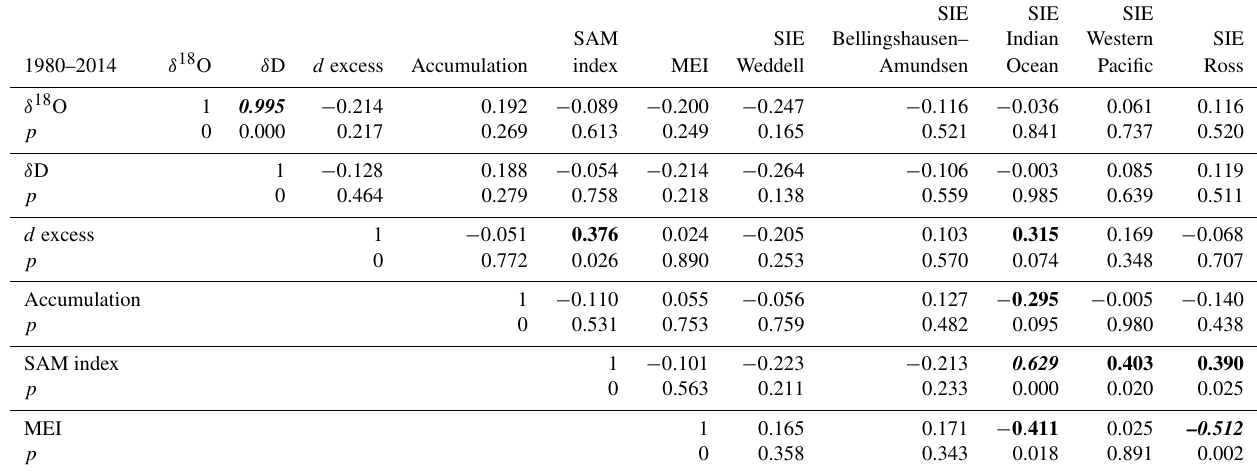
Table 2. Results of cross-correlation analysis for stable water isotope and accumulation composite records from UG and time series of the SAM index, multivariate ENSO index (MEI) and sea ice extent (SIE) in five different Antarctic sectors (annual means). Cross-correlations were calculated considering the record period that is covered by a minimum of three firn cores (1980–2014; excluding firn core GUPA-1). Prominent correlations with a low p value ( p < 0 . 1) are marked in bold and if statistically significant ( p < 0 . 01, α = 0 . 05) in bold and